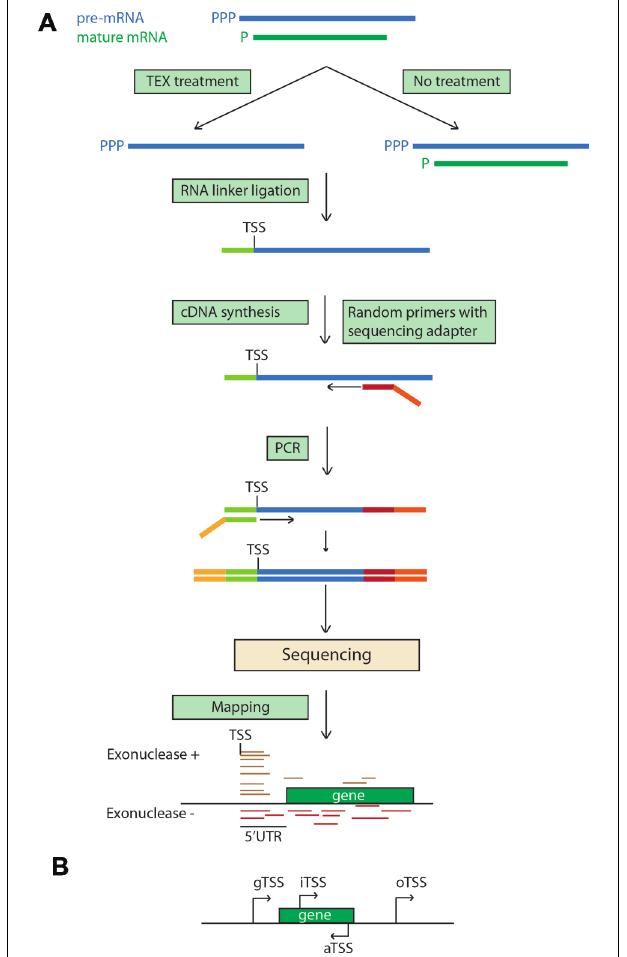
FIGURE 4 | Differential RNA-seq. (A) 5 (cid:2) monophosphorylated chloroplastic mature transcripts are degraded withTerminator 5 (cid:2) -phosphate-dependent exonuclease (TEX) in theTEX treatment, enriching the sample with pre-mRNAs.The 5 (cid:2) ends of the pre-mRNAs are enriched in the treated sample because they are protected by the triphosphate and theTEX treatment removes degraded mRNAs (Sharma etal., 2010).The enrichment can be enhanced by shearing the RNA before theTEX treatment. Sequencing reads starting exactly at the same nucleotide position in the exonuclease treatment denote the transcription start site. (B) Example of localization of differentTSS.TSS, transcription start site; gTSS, geneTSS; iTSS, internalTSS; aTSS, antisenseTSS; oTSS,